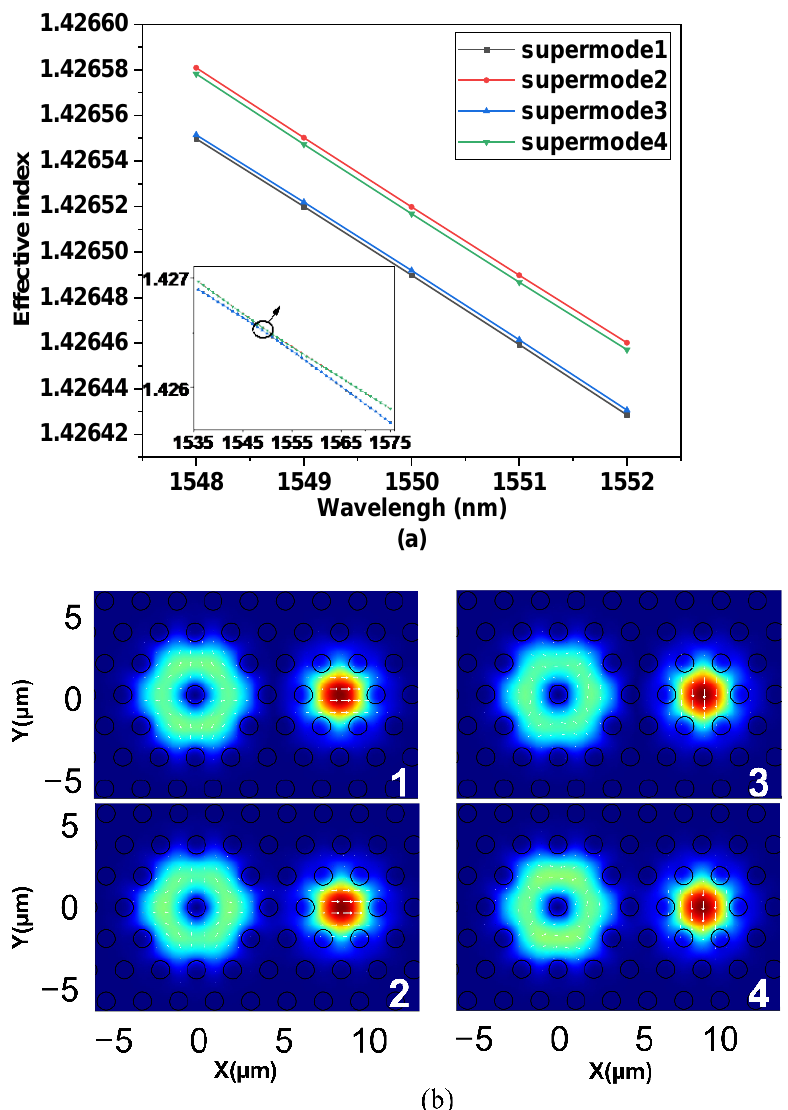
Figure 3. ( a ) Dispersion curves of the four supermodes created by the resonance between HE 11 and HE 21 modes. ( b ) Modal energy distributions of the four supermodes created by the resonance between HE 11 and HE 21 modes.